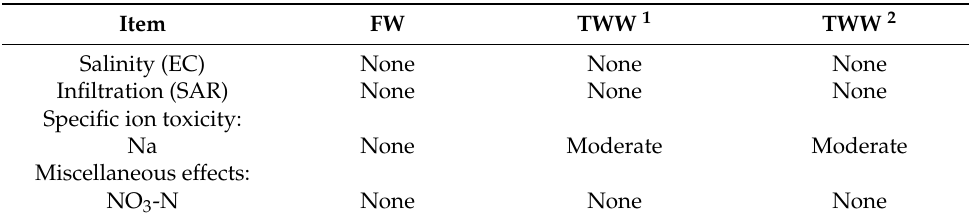
Table 5. Restrictions on use for irrigation with freshwater (FW) and urban treated wastewater (TWW) from HSSFs CW. Item FW TWW 1 TWW